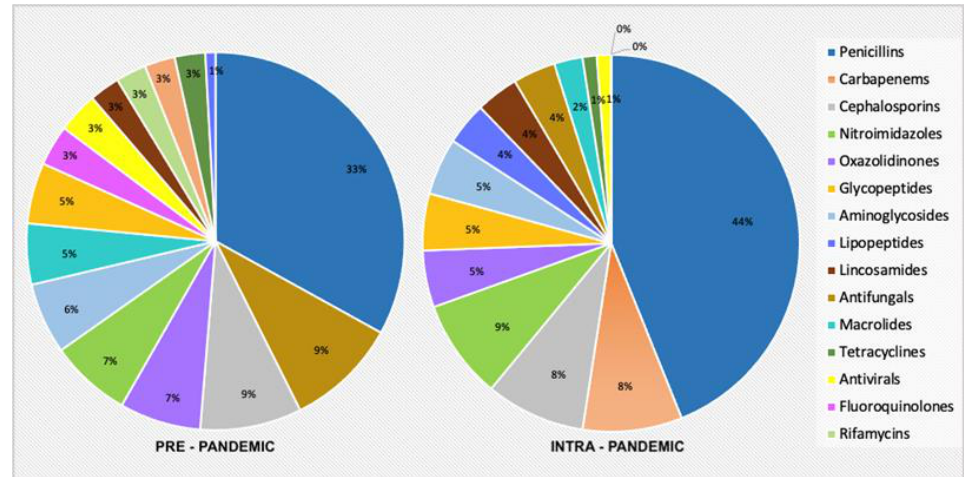
Figure 2. Comparison of different antimicrobial approaches before and during the pandemic. ( a ) Percentage of patients who underwent prophylactic, empiric and target therapy in the two study populations; ( b ) Number of days undergoing prophylactic, empiric and target therapy in the two years of analysis, i.e., pre-pandemic (2019) and intra-pandemic (2020). PP, pre-pandemic; IP, intra- pandemic.